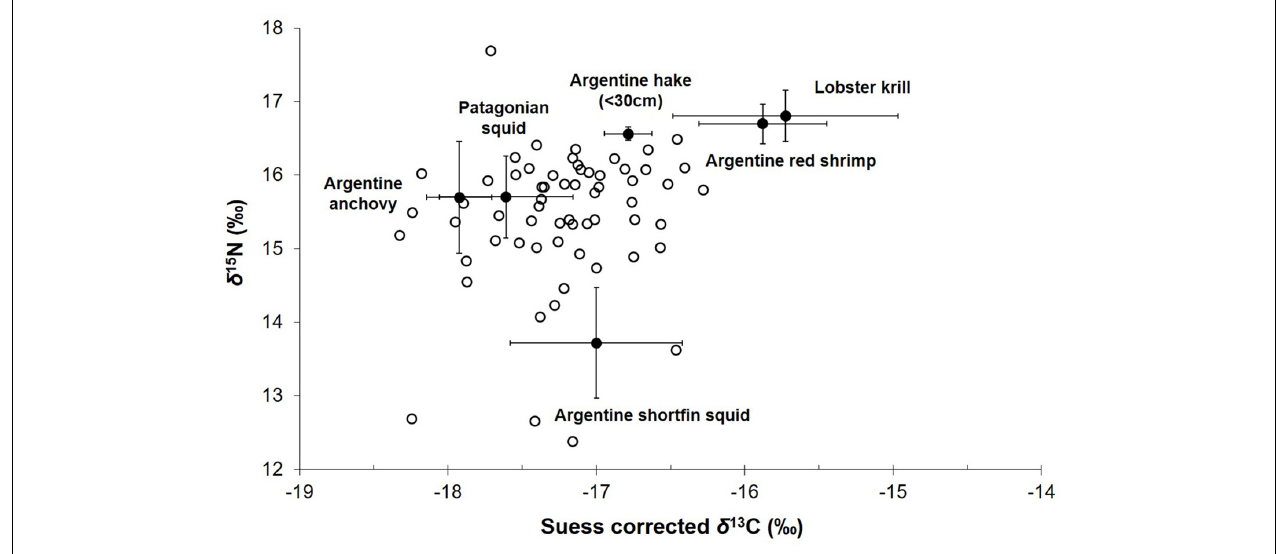
FIGURE 2 | δ 13 C– δ 15 N biplot showing the bivariated stable isotope ratios of subadult and adult male South American fur seals during the last 4 decades, after correcting for trophic discrimination factors (TDFs), and their main prey (mean ± SD) in the region of northern and central Patagonia.